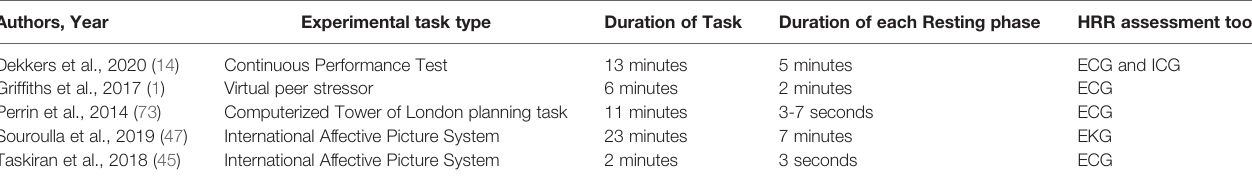
TABLE 3 | Characteristics of the Task-Related Heart Rate Reactivity Assessment in the Included Studies.